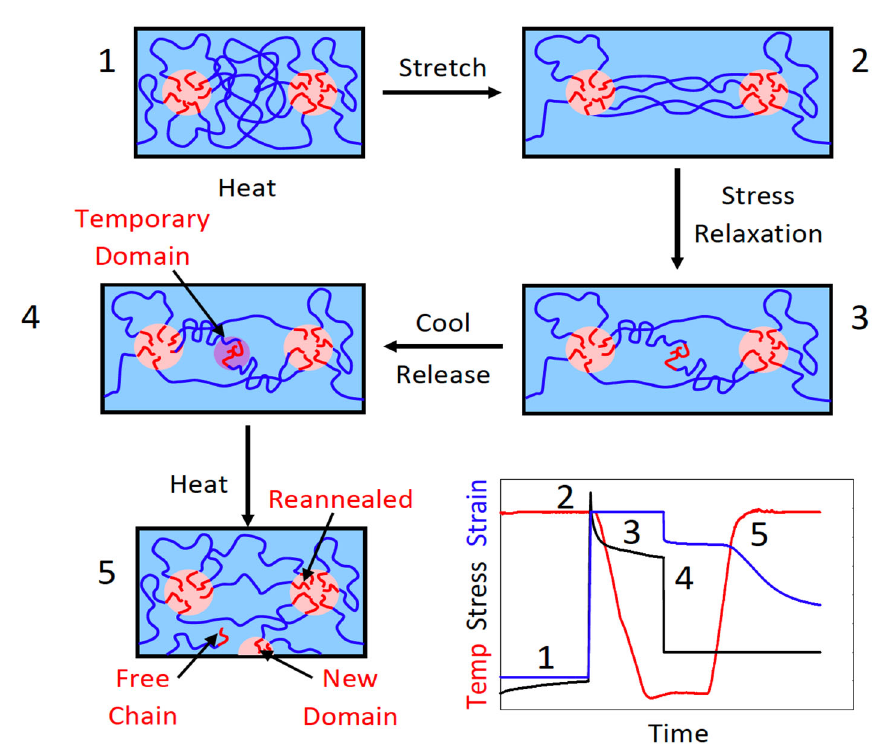
Figure 10. Mechanism of SBCs’ shape memory effect. The stress relaxation started when the sample was cooled down to room temperature (1 → 2). For unloading the sample, the fixed strain increased as the heating time increased (2 → 3). The constant recovery time increased with the increased heating time (3 → 4). This seemed to decrease both the recovery rate and the recovery extent. After heating the sample, it returned to its original state (4 → 5). Reprinted with permission from [49]. Copyright 2019 American Chemical Society.